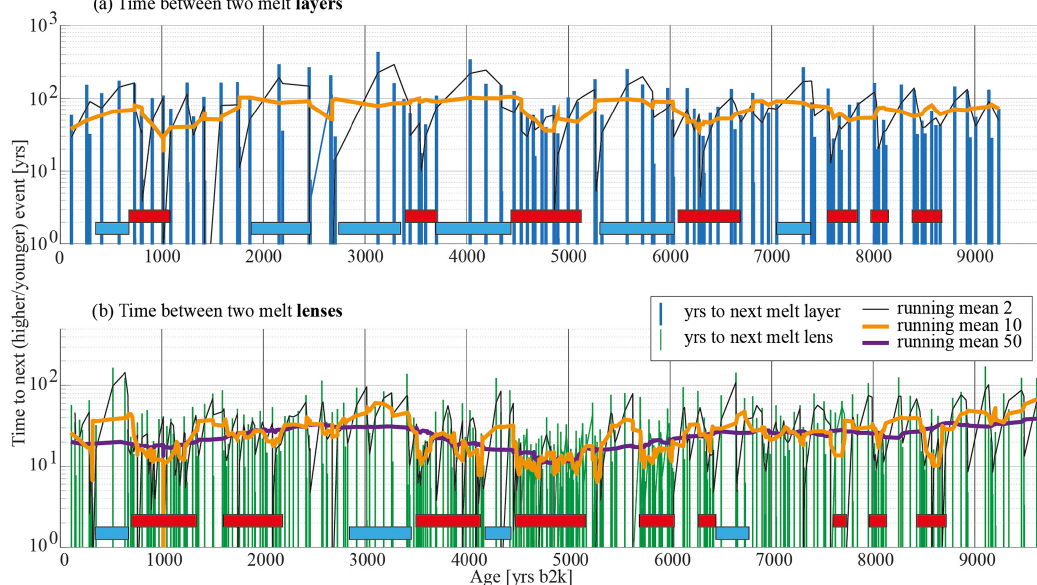
Figure A5. Time from an event to the next younger event for (a) 137 melt layers (vertical blue bars) and (b) 424 melt lenses (green bars). Different running means (averages with a moving window) are shown to visualize long-term variations. Red bars highlight periods with short spacing between events, and blue bars represent long spacing. Figure A6d shows the combination of melt layers and